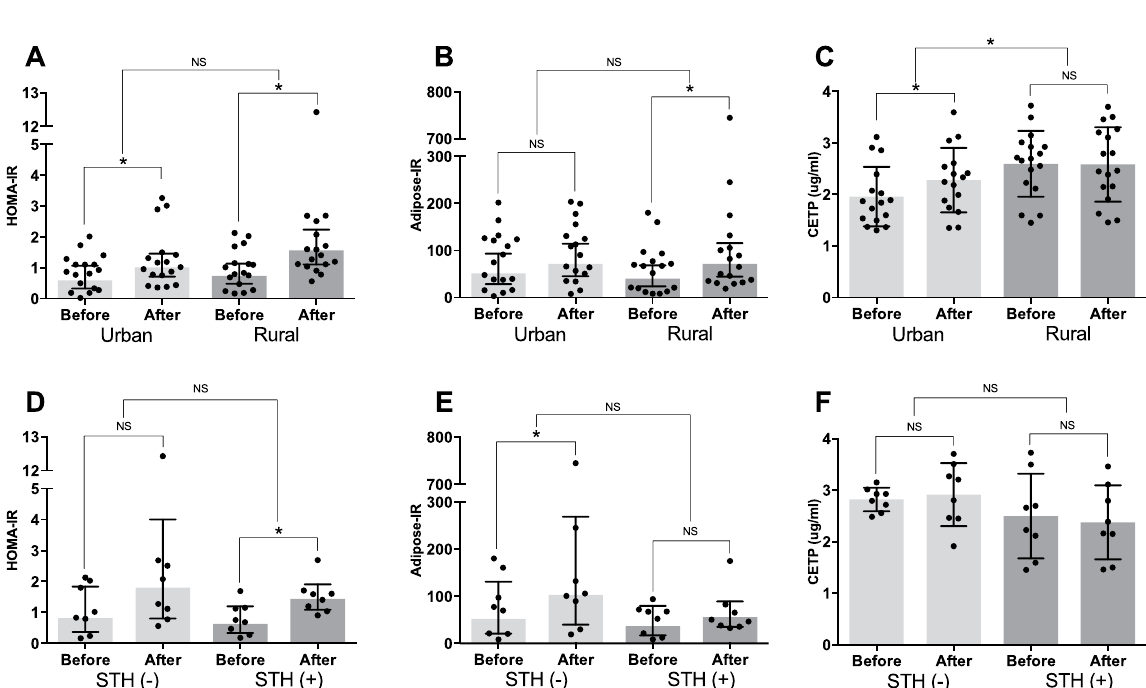
Figure 2. Comparison of Metabolic Responses to High-Fat Diet. HOMA-IR and adipose-IR index are presented as geometric mean and its corresponding 95% confidence interval, while CETP levels are presented as mean with its standard deviation. There were no significant differences in the increase of HOMA-IR ( A ), adipose-IR index ( B ) between urban and rural group, however, the increase in CETP level ( C ) was higher in the urban group. Furthermore, in rural group, there were no significant differences in the increase of HOMA-IR ( D ), adipose-IR index ( E ), and CETP level ( F ) between STH-infected and uninfected group. The difference between before and after intervention for each group was analysed using paired t-test, while the difference in the magnitude of changes for each parameter was analysed using linear mixed model ( * p < 0.05, NS: p >